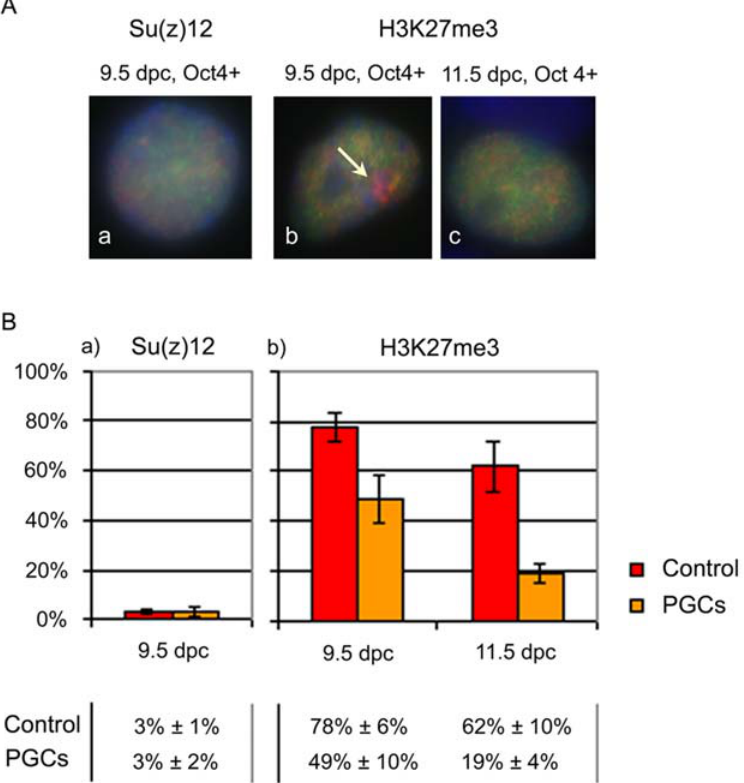
Figure 2. PRC2 and associated H3K27me3 on the inactive X chromosome in developing XX PGCs. (A) a) 9.5 dpc XX PGCs stained for Oct4 in green and Su(z)12 in red. Most PGCs showed diffuse nuclear staining for Su(z)12 and no detectable accumulation corresponding to Xi. b) 9.5 dpc and c) 11.5 dpc XX PGCs stained for Oct4 in green and H3K27me3 in red. At 9.5 dpc approximately 50% of Oct4 positive cells showed H3K27me3 Xi foci (arrow) while at 11.5 dpc most Oct4 positive cells showed only diffuse nuclear staining for H3K27me3 and no detectable accumulation on the Xi. (B) Scoring results for a) Su(z)12, and b) H3K27me3. Plots represent the percentage of Oct4 positive (PGCs) and Oct4 negative (control) cells showing a Su(z)12, or a H3K27me3 Xi signal; error bars represent variation between embryos. Su(z)12 data corresponds to the analysis of 8 embryos/slides; a total of 545 Oct4 positive cells and 1649 Oct4 negative cells were scored. H3K27me3 data corresponds to the analysis of 6 and 7 embryos/slides for 9.5 dpc and 11.5 dpc respectively; a total of 274 (at 9.5 dpc) and 1099 (at 11.5 dpc) Oct4 positive cells were scored, over 1400 cells were scored in controls.